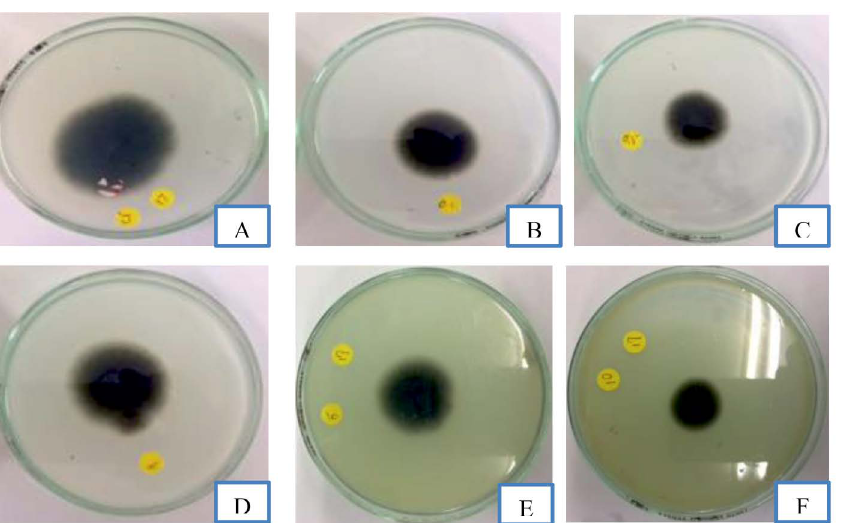
Fig. 4. Mycelia growth of Isolate 2 of P.grisea in response to control (A), 0.1 mg/mL (B), 0.5 mg/mL (C), 1 mg/mL (D), 5 mg/mL (E) and 10 mg/mL (F), respectively of Commela communis L. extract on PDA Table 6. Effect of methanol extract of day flower to different isolates (mg/mL) Isolates IC 50 Isolate 1 41.34 a Isolate 2 Isolate 3